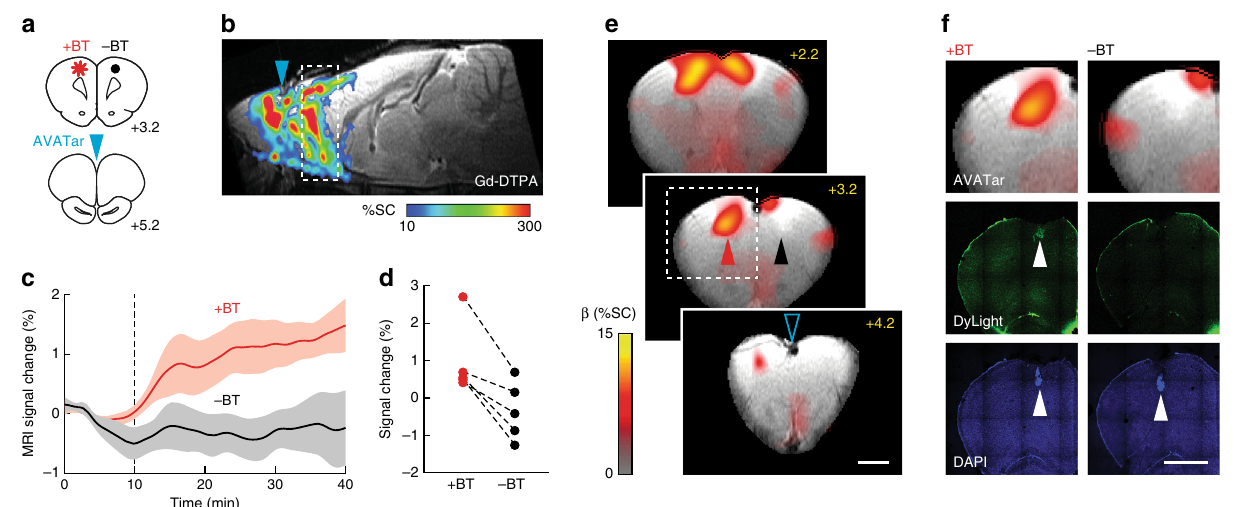
Fig. 4 In vivo molecular imaging with BT-AVATar. a Brain atlas 57 sections (bregma coordinates noted) showing positions of test ( + BT, red) and control ( − BT, black) cell implants and intra-CSF AVATar infusion for in vivo mapping experiments. b Wide- fi eld probe delivery illustrated using Gd-DTPA infused at the AVATar infusion position (blue arrowhead). Color scale illustrates signal changes (%SC) produced by the contrast agent. c Signal change over time near test ( + BT, red) and control ( − BT, black) cells. Dashed line indicates start of AVATar infusion. Shading denotes SEM of n = 5. d Signal enhancements in individual animals at + BT (red) and – BT (black) sites. e Map of regression coef fi cients ( β , in units of %SC) illustrating responses near + BT cell implant locations (red arrowhead) but not – BT controls (black arrowhead). BT-AVATar was infused 1 mm anterior to the open blue arrowhead. Displayed brain slices correspond to the dashed region in b . Scale bar = 2 mm. f Comparison of MRI results with histology shows overlap of BT-AVATar signal with position of test implants (left images) but not control implants (right images). Top row: closeup of the dashed region in e (left), containing + BT cells, juxtaposed with the symmetric region containing – BT cells (right). Middle row: selective activation of BT-AVATar by biotinylated cells is con fi rmed by visualization of biotinylated cells (left, arrowhead) but not unbiotinylated cells (right) following infusion of fl uorescent BT-AVATar formulated with DyLight-labeled SA. Bottom row: visualization of both test and control xenografts (arrowheads) by DAPI staining. Scale bar = 2